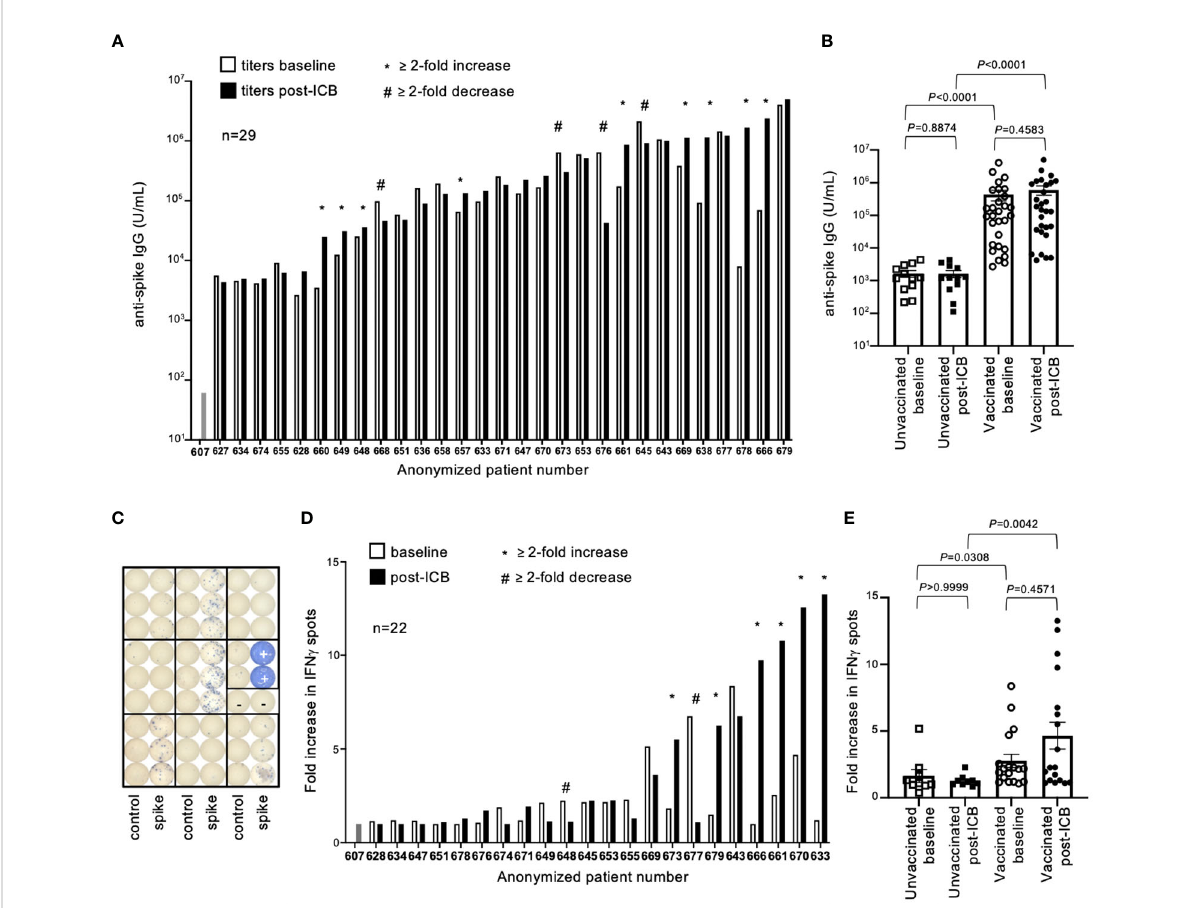
FIGURE 2 SARS-CoV-2 spike protein antibody titers and T cell responses in vaccinated patients before and after immune checkpoint blockade. (A) Antibody (IgG) titers to SARS-CoV-2 spike protein were quanti fi ed for 29 previously vaccinated patients at baseline (open bars) and following two rounds of ICB infusion (closed bars). Antibody titers were compared to a pre-COVID control (patient #607). Each bar represents data from an individual patient, with responders (*) and negative responders (#) indicated. (B) Vaccinated patient titers were evaluated as a group at baseline and post-ICB and compared to unvaccinated patients that received ICB in the same timeframe. Bars represent average titer, and error bars are SEM for each cohort. Each point represents data from an individual patient. (C) Image of ELISPOT plate provides visual demonstration of differences in IFN g spots generated from stimulation of PBMCs with either control peptide, speci fi c peptide spanning the SARS-CoV-2 spike protein, or PHA positive control (+). (D) Quanti fi cation of T cell responses to SARS-CoV-2 spike protein from 22 individual vaccinated patients at baseline (open bars) and post-ICB (closed bars), (E) grouped by treatment cohort, and compared to unvaccinated patients. Bars represent average fold increase, and error bars are SEM for each cohort. Each point represents data from an individual patient. Exact P values are provided for the bracketed